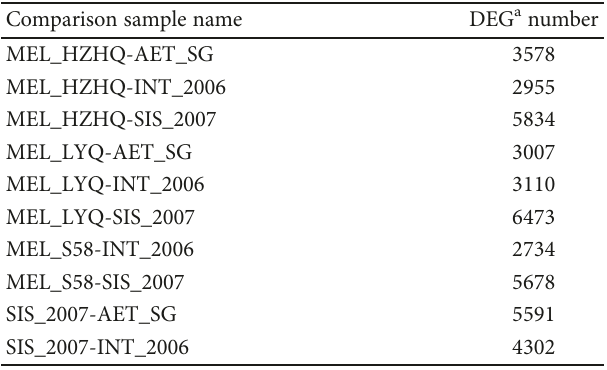
Table 4: The number of genes with expression changes in interspeci fi c